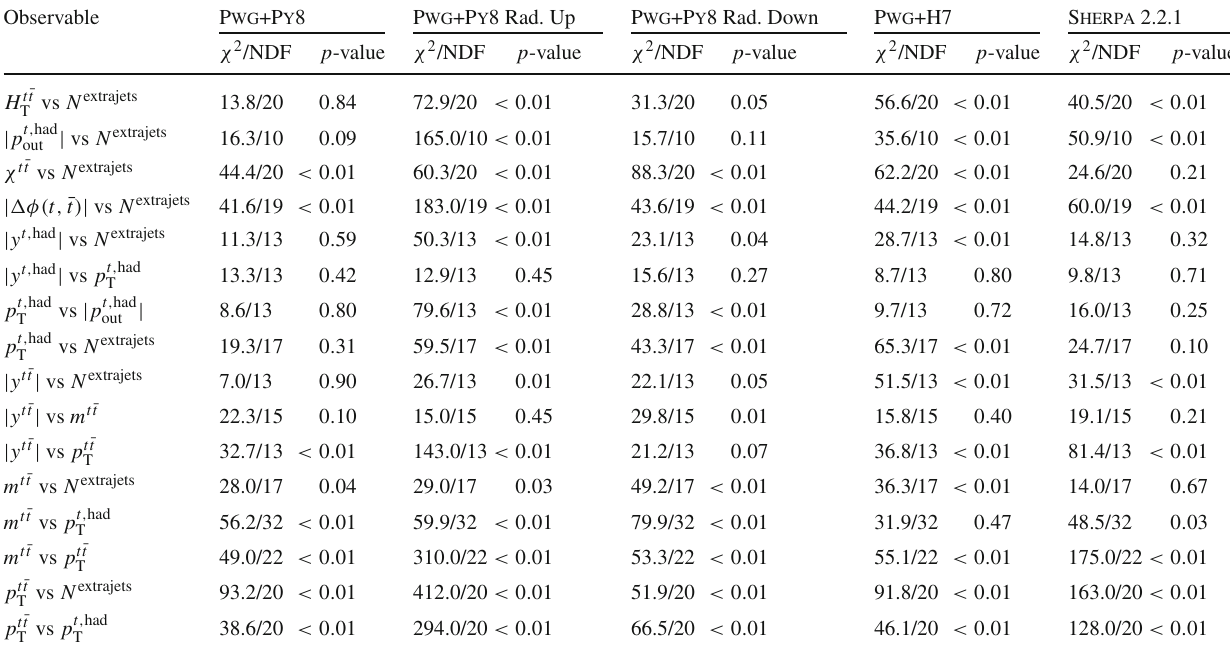
Table 12 Comparison of the measured particle-level absolute double- differential cross-sections in the resolved topology with the predictions from several MC generators. For each prediction a χ 2 and a p -value are